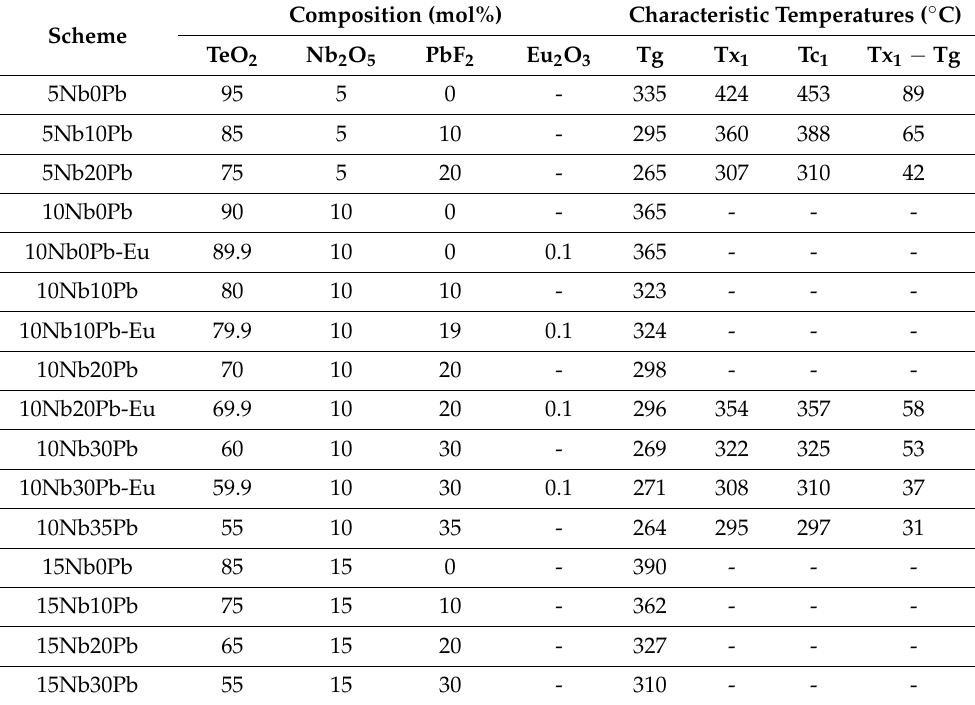
Figure 1. Glass-forming domain in the ternary system TeO 2 -Nb 2 O 5 -PbF 2 . Table 1. Samples label, molar composition and characteristic temperatures.